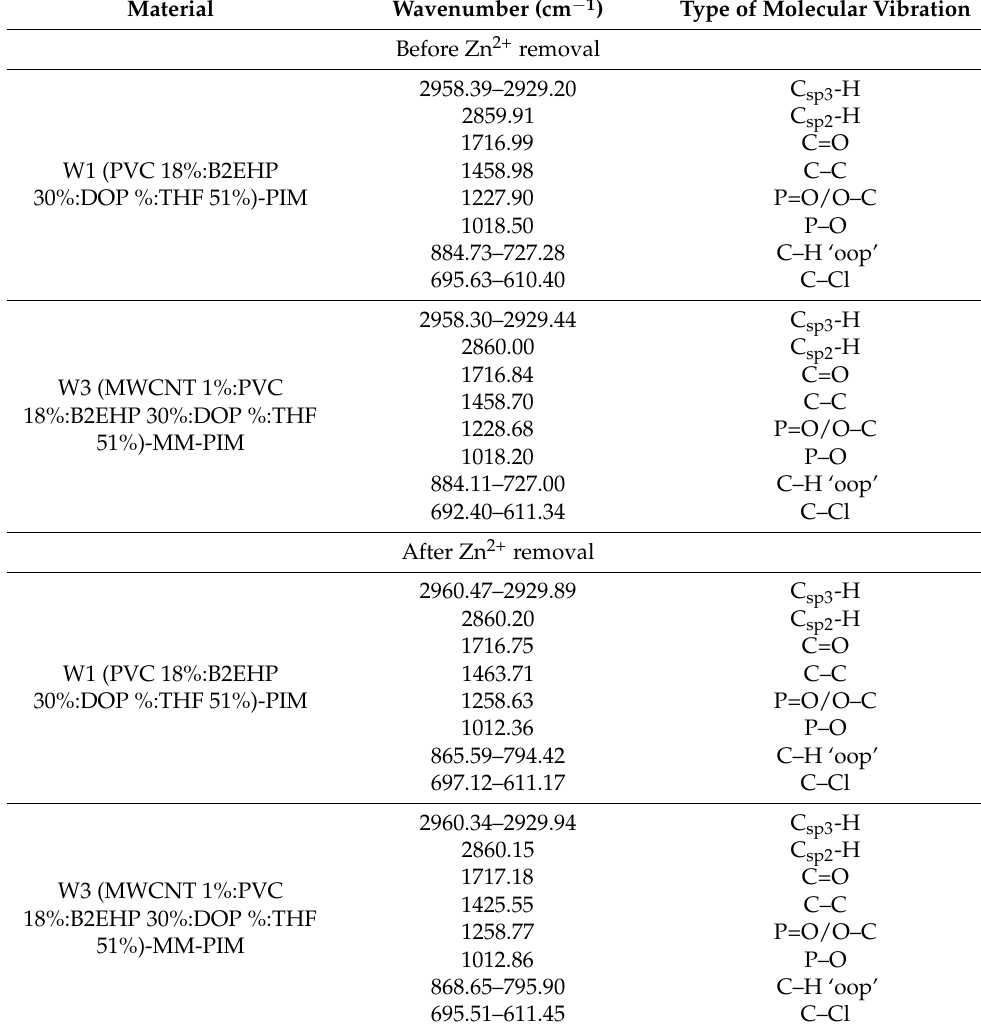
Table 3. The wavenumbers of significant peaks observed in the FTIR spectra of the W1 (PIM) and W3 (MM-PIM)